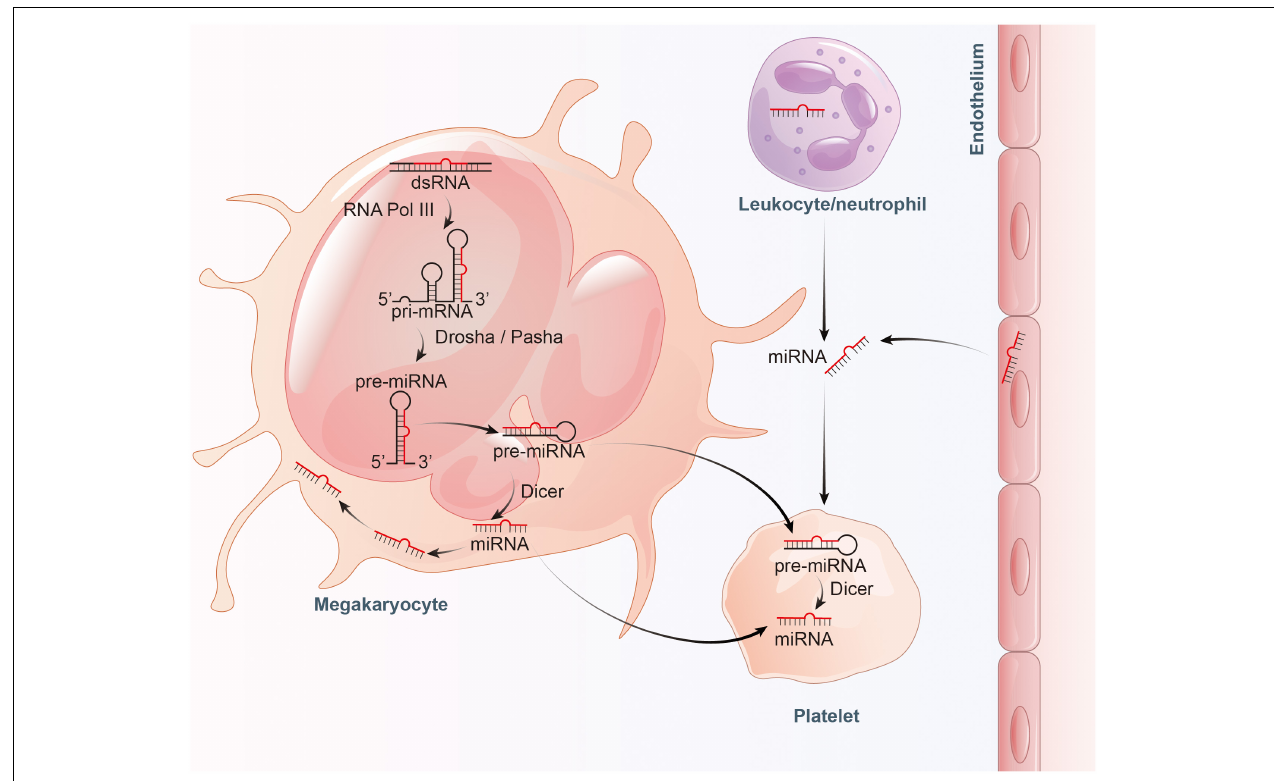
FIGURE 1 | Proposed model for the inheritance and operation of platelet miRNAs. On the one hand, platelets inherit precursor miRNA (pre-miRNA) from megakaryocytes and process them into mature miRNA by Dicer. On the other hand, platelets also inherit mature miRNA from megakaryocytes, and absorb miRNA from endothelial cells and